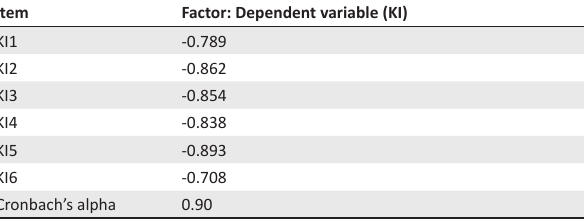
TABLE 2: Factor structure of the dependent